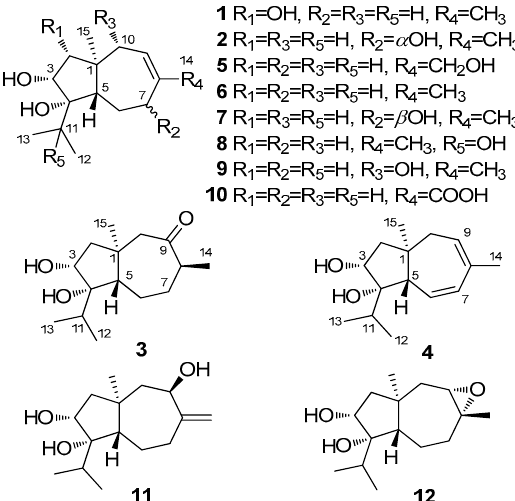
Figure 1. Structures of compounds 1 − 12 .